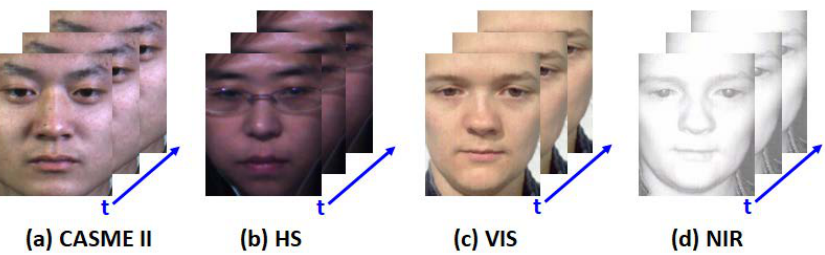
Figure 2. Sample Examples of Four ME Sample Sets Used in the Evaluation